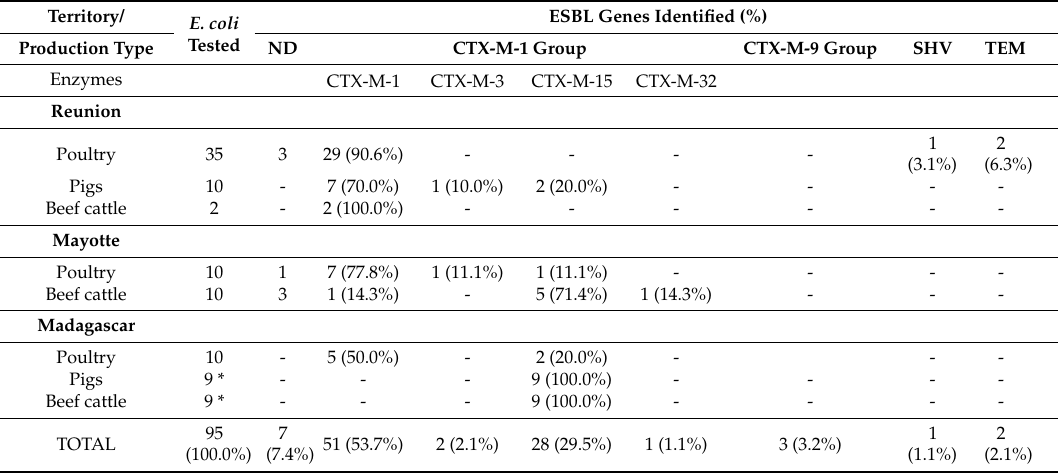
Table 4. ESBL genes identified in a subset of E. coli isolated from poultry, pig and beef cattle production farms in Reunion, Mayotte and Madagascar,